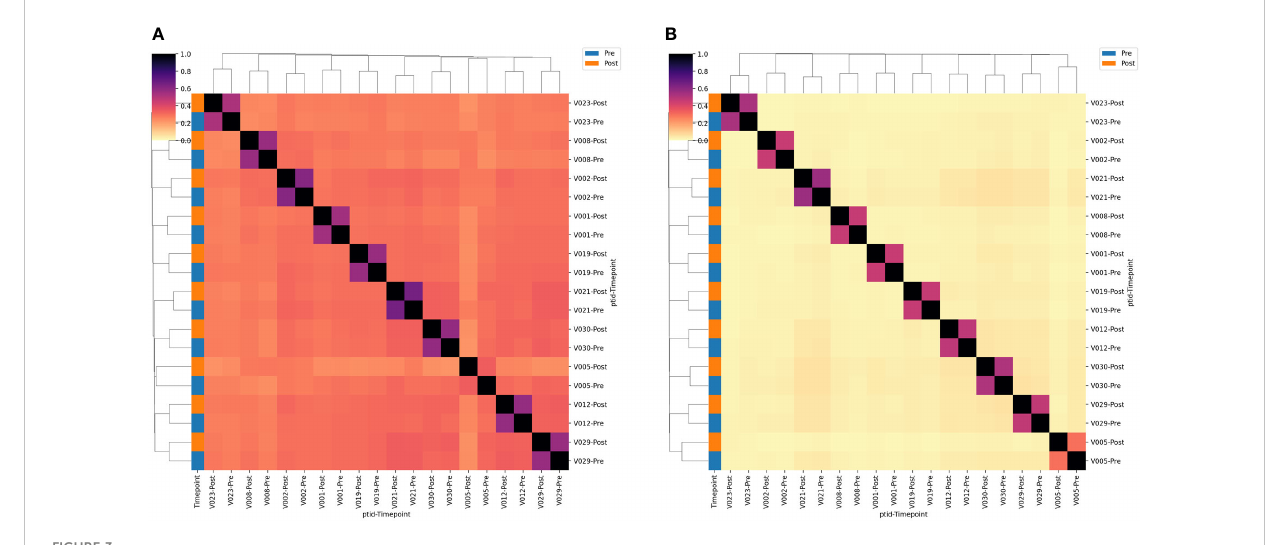
FIGURE 3 TCR single-chain repertoire sharing. Heatmaps showing the (A) TRGV9*01+ and (B) TRDV2*01+ clonotypes shared between pairs of samples. Sharing constitutes a single-chain clonotype that matches in the V-gene, J-gene and CDR3 amino acids (proportion shared = 2*N shared /[N A + N B ]). Samples are labeled according to the volunteer number (VX) and the timepoint relative to BCG vaccination. Sample timepoint is also indicated by the color